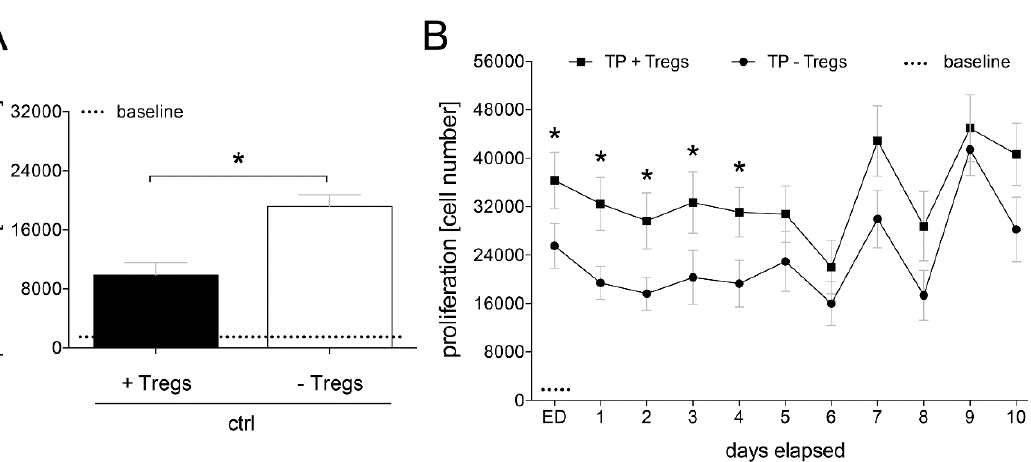
Figure 3. CD4 + T lymphocytes were isolated from healthy volunteers (ctrl) or major trauma patients (TP) and depleted from regulatory T cells (Tregs) over a 10-day time course after admission (emergency department, ED-10). ( A ): The proliferation rates in absolute cell numbers of CD4 + cells